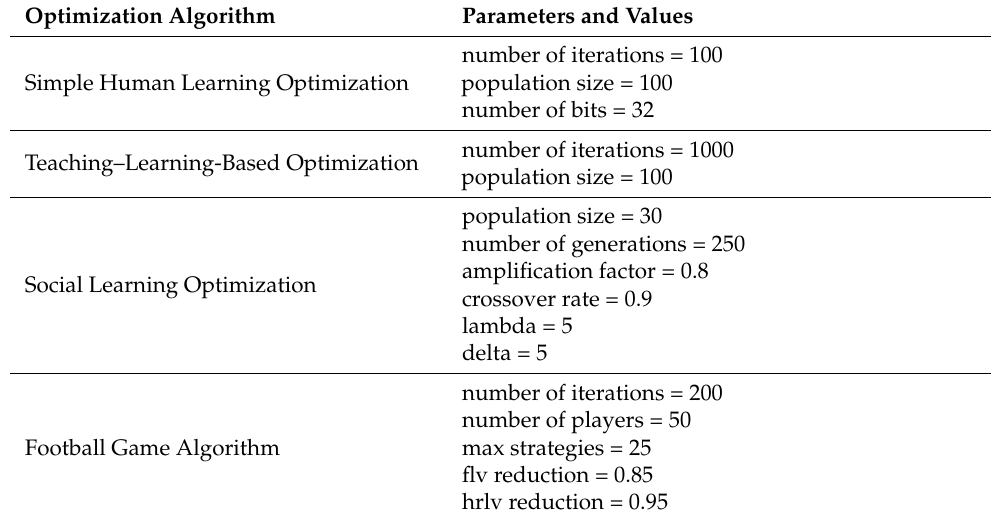
Table A1. The parameters values of the algorithms considered for the optimization of CO and CH 4 . Optimization